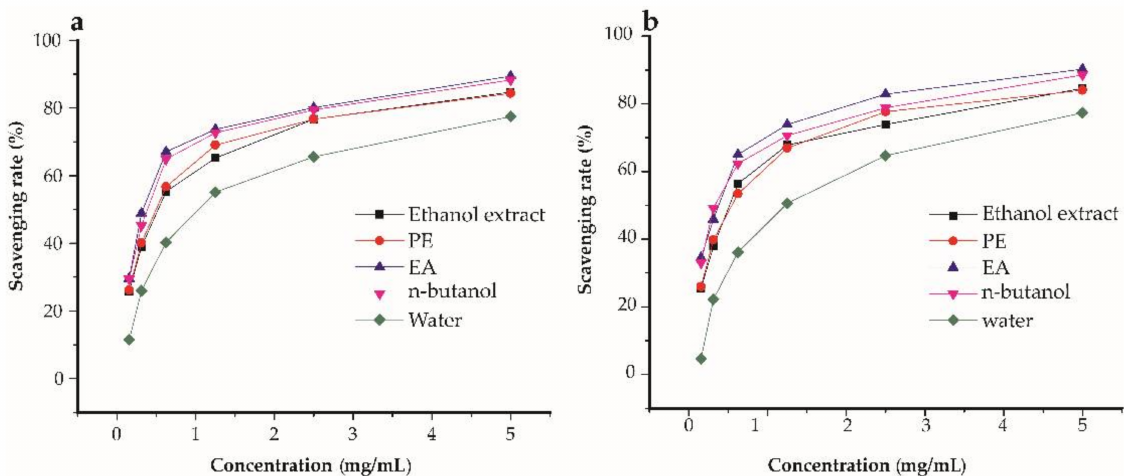
Figure 2. The percentage (%) scavenging rates of ethanol extracts, petroleum ether (PE), ethyl acetate (EA), n -butanol, and water fractions of Ficus glumosa . ( a ) The % radical scavenging rates of DPPH (2,2-diphenyl-1-picrylhydrazyl) assay, and ( b ) ABTS (2,2 (cid:48) -azino-bis (3-ethylbenzothiazoline-6-sulfonic acid) assay exhibited by ethanol extracts, PE, EA, n -butanol, and water fractions of Ficus glumosa .